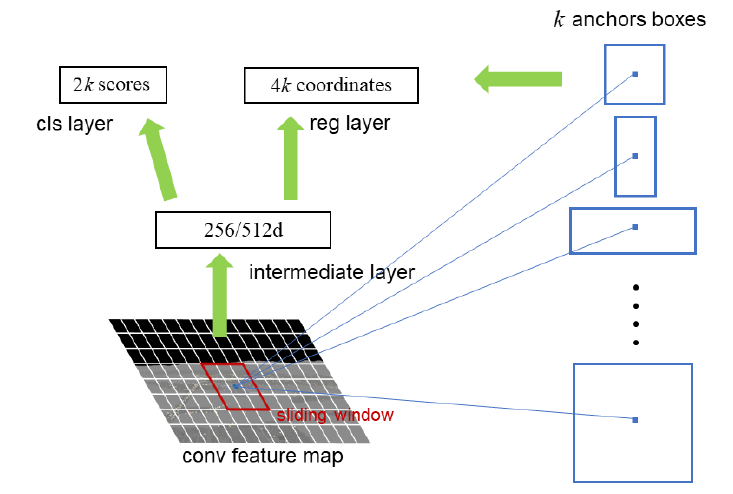
Figure 4. Illustration of RPN